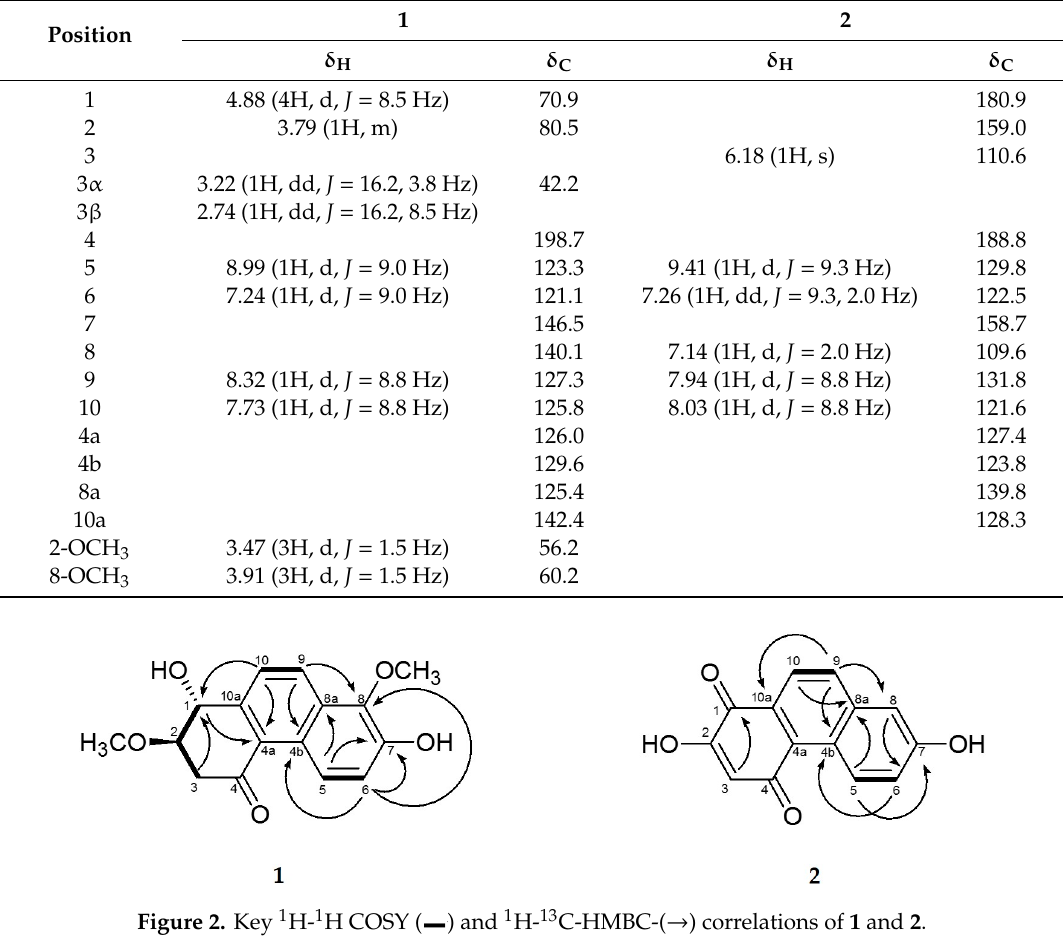
→ ) correlations of 1 and 2 .